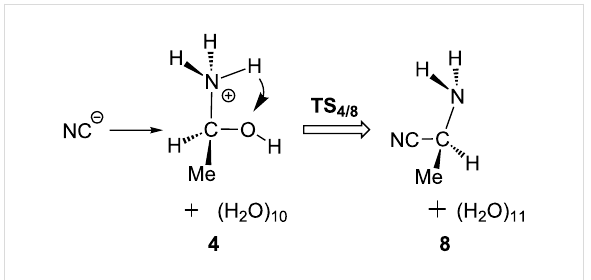
Scheme 6: A short-cut path by the nucleophilic displacement and the concomitant proton transfer. “The first bypass” in Scheme